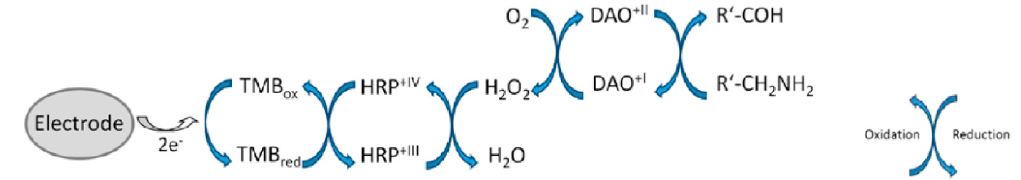
Figure 1. A redox cascade is used for the indirect detection of biogenic amines. The oxidation of biogenic amine by DAO reduces O 2 to H 2 O 2 . In a second reaction, the generated H 2 O 2 is used to oxidize a co-substrate (TMB) catalyzed by horseradish peroxidase (HRP). Reduction of the co-substrate at a working electrode induces a current which directly correlates with the amount of biogenic amines in the